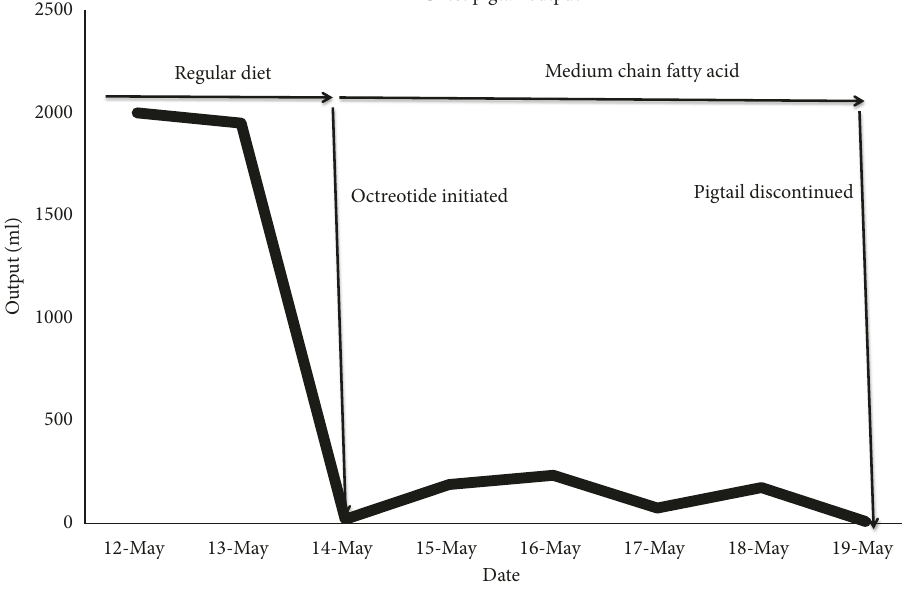
Figure 4: Chest pigtail catheter output over